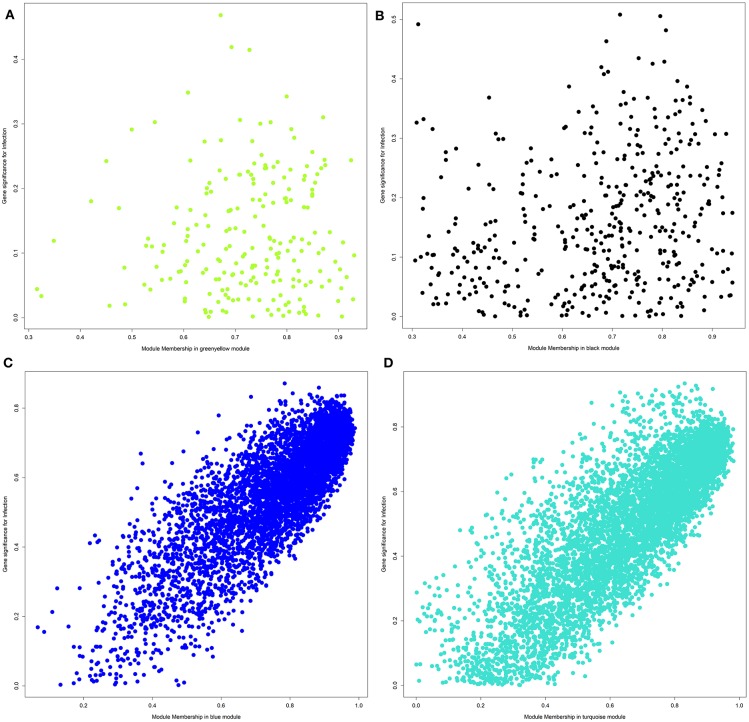
Plot of module membership against the correlation between normalized gene expression and infection category for each gene within a module. (A) Module greenyellow; (B) module black; (C) module blue; (D) module turquoise.